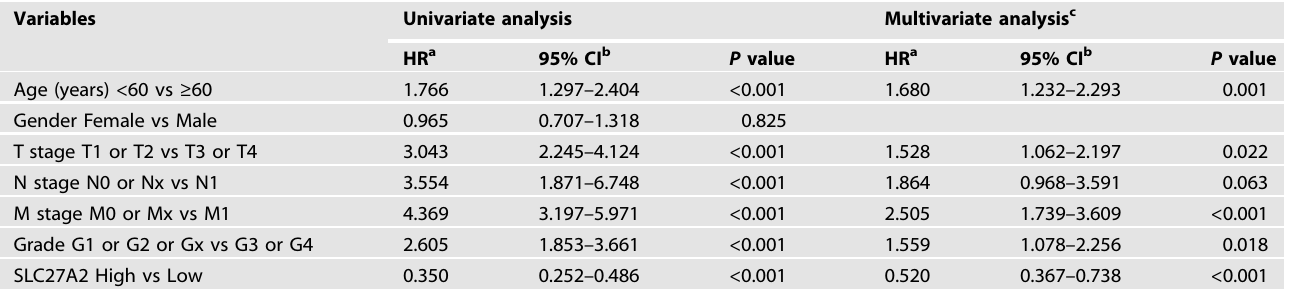
Fig. 2 Aberrant expression of SLC27A2 was signi fi cantly associated with different clinical features. A – C SLC27A2 mRNA expression in three Oncomine subsets, including Gumz, Jones and Lenberg renal statistics, ** p < 0.01, *** p < 0.001, and **** p < 0.0001. D – H SLC27A2 expression in TCGA-KIRC datasets, including cancer versus para-cancer, T stage, M stage, G stage, and TNM stage. Table 1. Univariate and multivariate analyses of risk score and patient overall